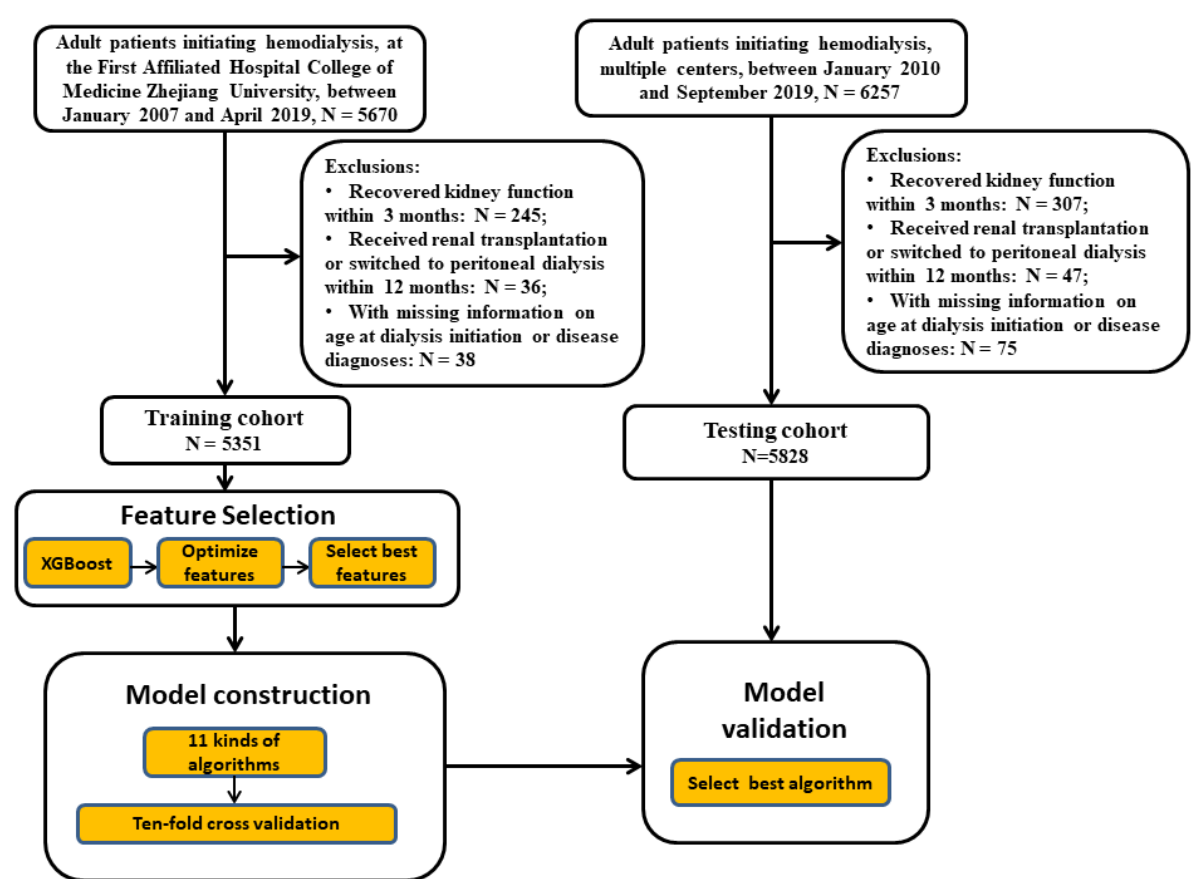
Figure 1. A workflow to develop the prediction models for first-year mortality in incident hemodialysis patients. XGBoost: extreme gradient boosting.